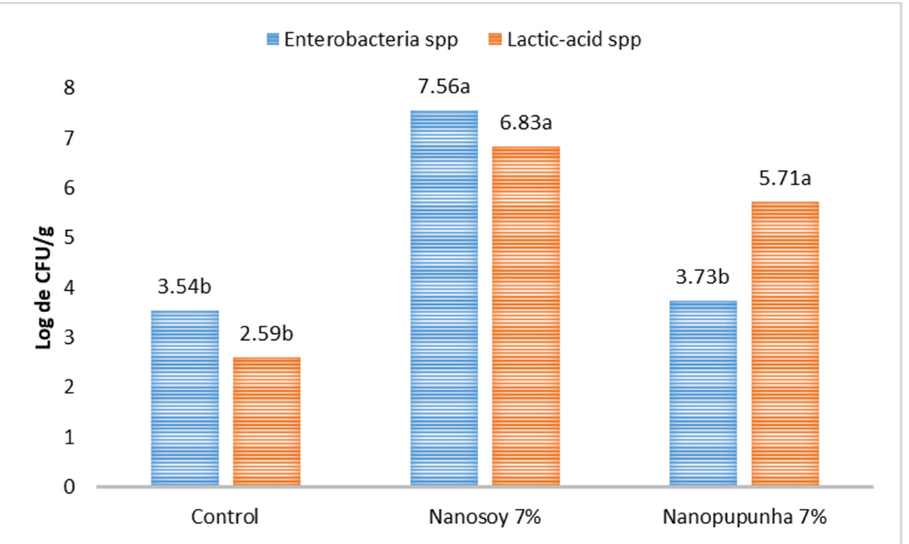
Figure 4. Count of Enterobacteriaceae spp. and lactic ‐ acid bacteria (log CFU/g) in the cecum of growing rabbits fed different diets viz., Control, Nanosoy, and Nanopupunha. Lowercase letters differ statistically based on Tukey’s test ( p < 0.05).